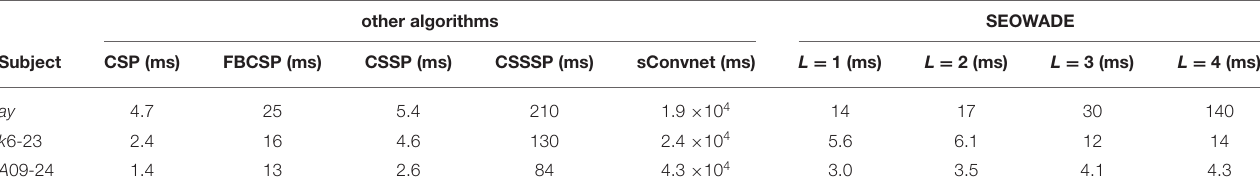
TABLE 4 | Runtimes (millisecond) of CSP, FBCSP, CSSP, CSSSP, shallow Convnet (abbreviated as sConvnet here), and SEOWADE (with DB7 implemented as the orthogonal wavelet) applied to the representative examples ay , k 6-23, and A 09-24. other